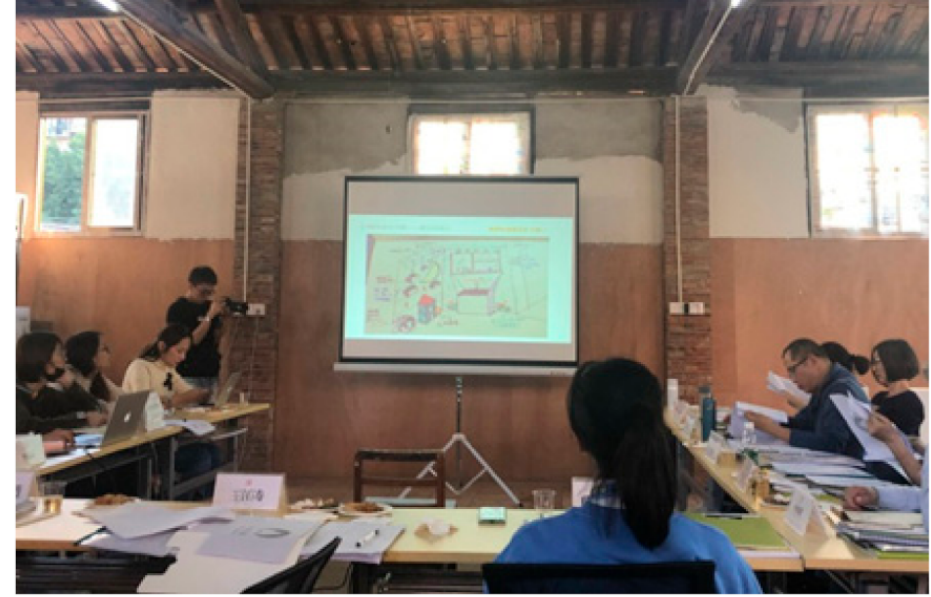
Figure 3. The discussion of the tourism routes focused on protecting heritage